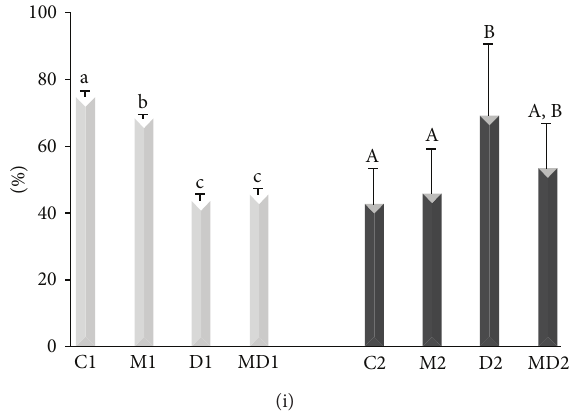
Figure 2: Immunohistochemistry ((a)–(h)) for the androgen receptor and quantification of AR-positive cells (i) in the acinar epithelium of rat ventral prostate (brown nuclei). (a) Short-term control (C1); (b) short-term control treated with MLT (M1); (c) short-term untreated diabetic (D1); (d) short-term diabetic treated with MLT (MD1); (e) long-term control (C2); (f) long-term control treated with MLT (M2); (g) long- term untreated diabetic (D2); (h) long-term diabetic treated with MLT (MD2). e: epithelium; l: lumen; s: stroma; arrow: AR-positive cells. Magnification: 400x, bar = 25 𝜇 m. (i) AR-positive epithelial cells frequency (%); light bars: short-term experiment and dark bars: long-term experiment ( 𝑁 = 5 animals/group). Different lowercase letters indicate significant differences between experimental groups C1, M1, D1, and MD1 (parametric data), and different capital letters indicate significant differences between groups C2, M2, D2, and MD2 (nonparametric